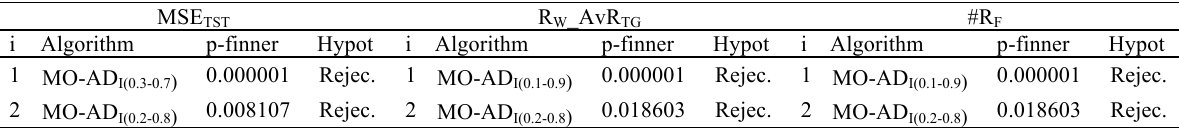
Table A.9 Finner Table with α = 0.05 for the methods on MSE TST , R W _AvR TG and #R F measures on MAX INT point